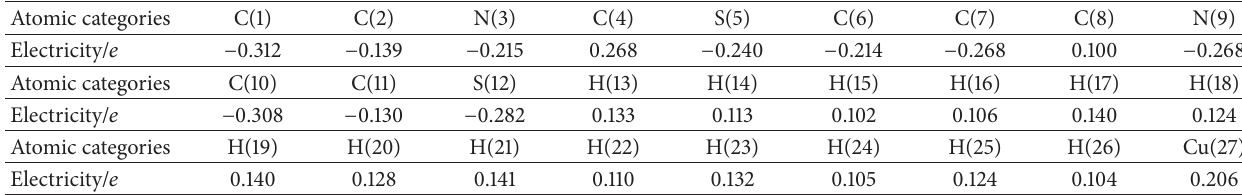
Table 3: Mulliken charge distribution of each atom of NND interaction with copper ion.